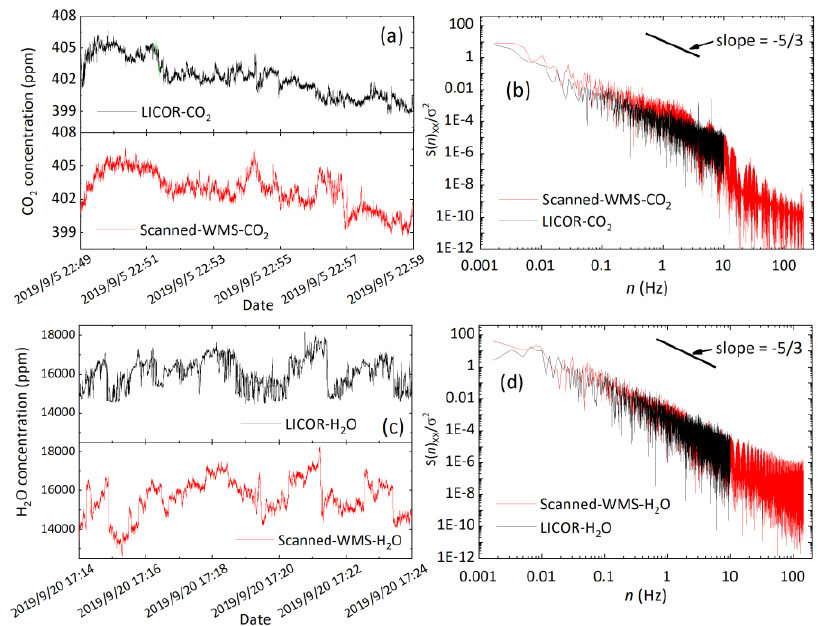
Figure 11. Comparison measurements by our scanned-WMS- θ 1f sensor and a LICOR instrument over a duration of 10 min. ( a ) CO 2 measurements and ( b ) the corresponding power spectra; ( c ) H 2 O measurements and ( d ) the corresponding power spectra.